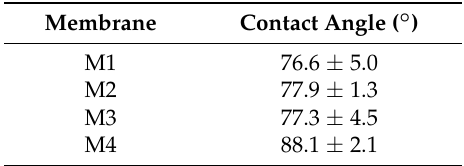
Table 1. Average contact angles measured using the sessile drop method.